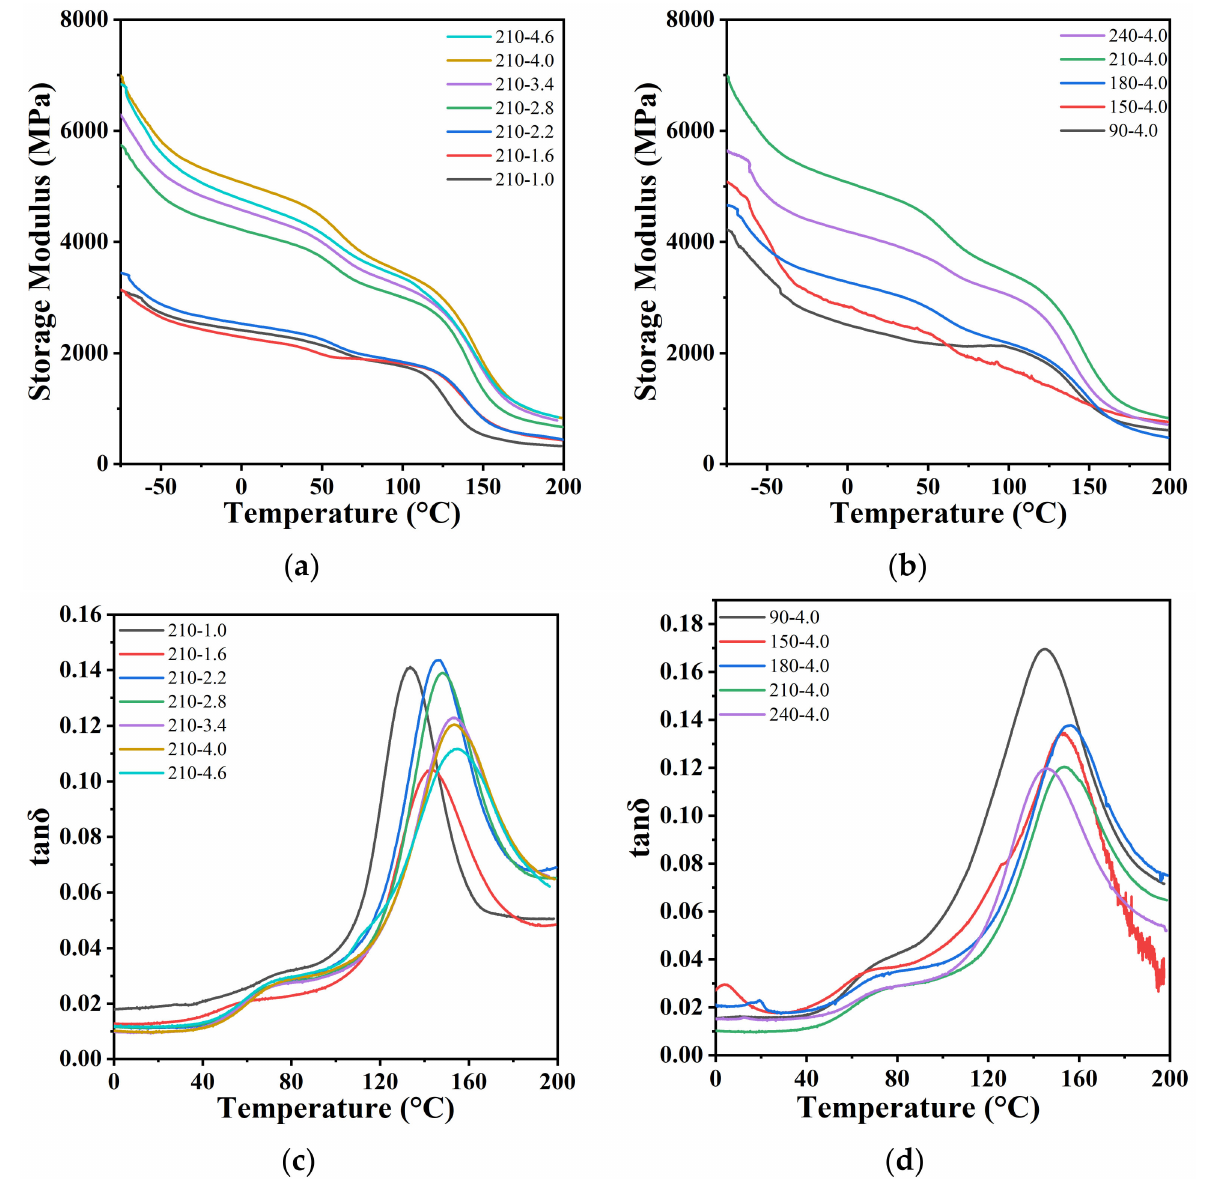
Figure 10. ( a , b ) Storage modulus–temperature curves and ( c , d ) tan δ –temperature relationship curves of PA12T samples with different stretching ratios or